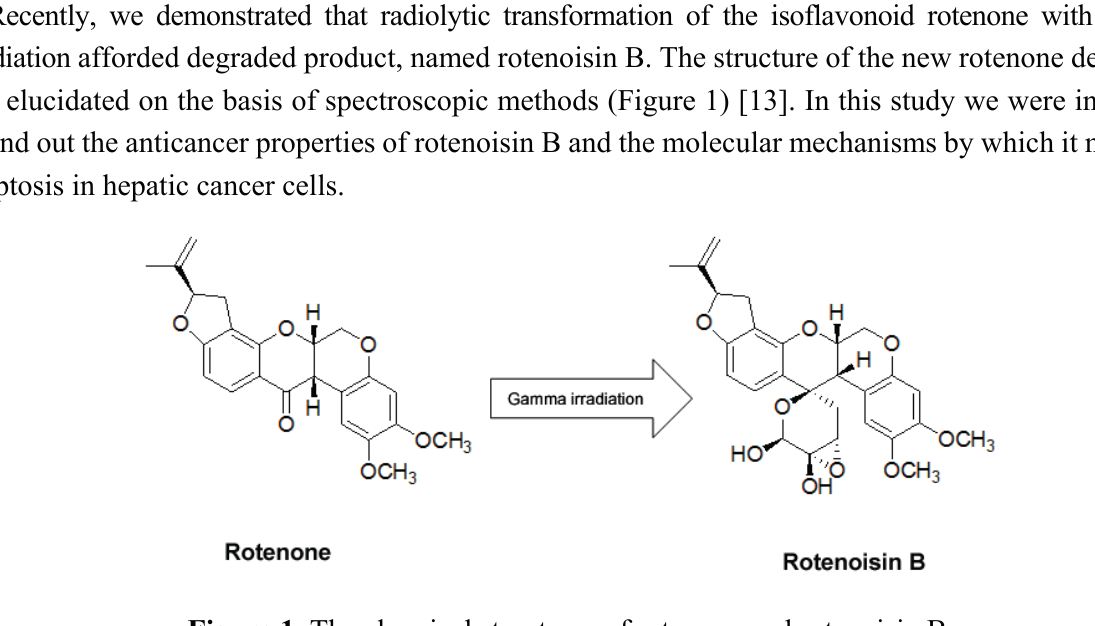
Figure 1. The chemical structures of rotenone and rotenoisin